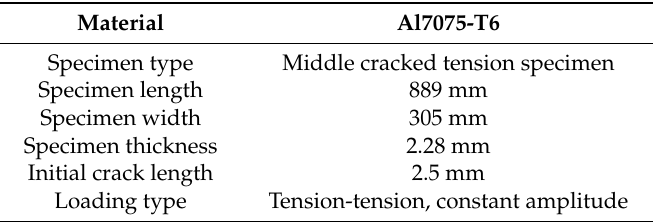
Table 1. The experimental information of Al7075-T6.